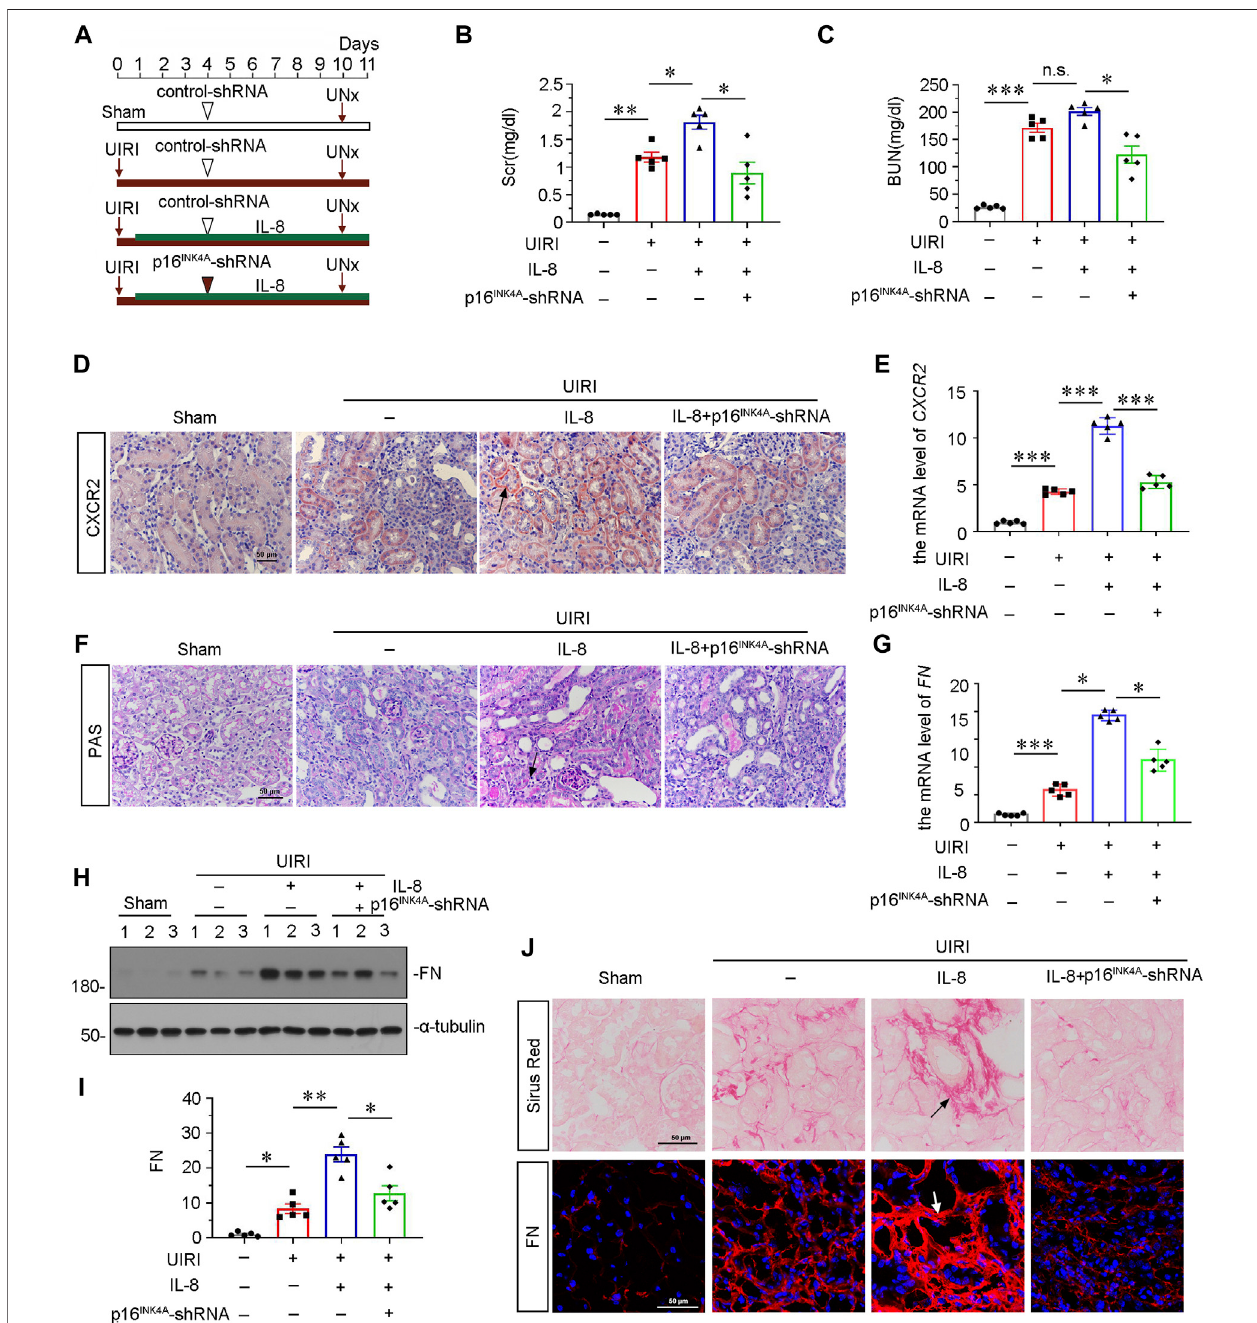
FIGURE 4 | Knockdown of p16 INK4A inhibits IL-8-aggravated renal fi brosis in UIRI mice. (A) Experimental design. Triangle shows the injection of control-shRNA or p16 INK4A -shRNA plasmid. Red arrows show the time of renal UIRI surgery and uninephrectomy. Green line segment indicates the injections of IL-8 (50 ng per time). (B, C) Graphic presentations show (B) Scr levels and (C) BUN levels in four groups. * p < 0.05, ** p < 0.01, *** p < 0.001, n = 5. (D,E) Graphic presentations show representative micrographs ofCXCR2expression (D) and relative abundanceof CXCR2 mRNA (E) indifferentgroups. Arrows indicate positivestaining.Scale bar, 50 μ m. (F) Representative micrographs show collagen deposition. Paraf fi n renal sections were subjected to periodic acid-Schiff (PAS) staining. Arrow indicates positive staining.Arrowsindicatepositivestaining.Scalebar,50 μ m. (G) Graphicalrepresentationsshowtherelativeabundanceof FN mRNAindifferentgroups.* p < 0.05,*** p < 0.001, n = 5. (H,I) Representativewesternblot analysis and quantitativeresults show the protein expressional levels of FNin each group. * p < 0.05, ** p < 0.01, n = 5. (J) Representative micrographs showing Sirus Red staining, and FN expression in four groups, as indicated. Frozen sections were stained with immuno fl uorescence staining for FN. Paraf fi n-embedded sections were stained by Sirus Red staining. Arrows indicate positive staining. Scale bar, 50 μ m.